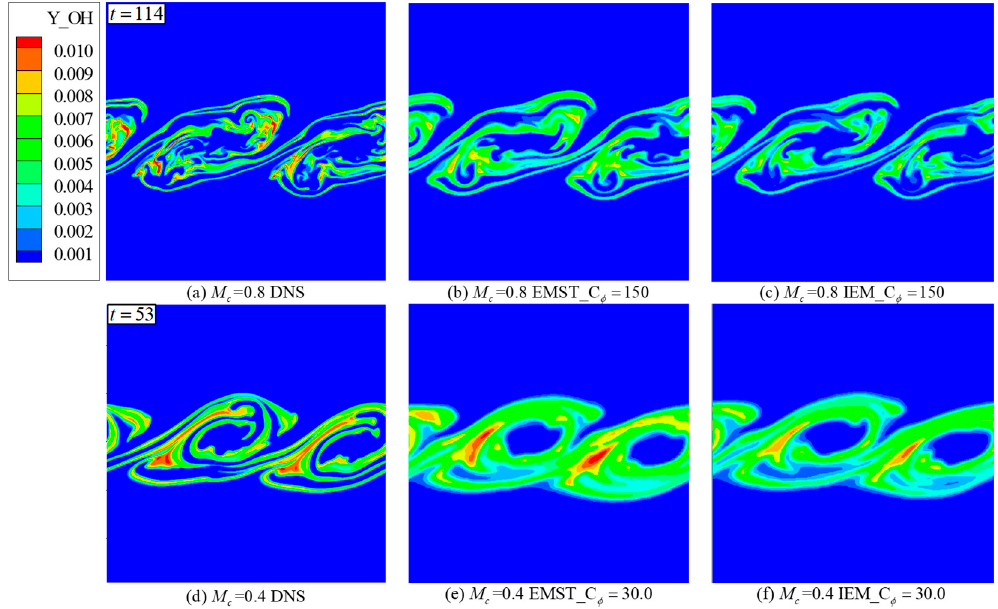
Figure 11. Instantaneous results of OH mass fraction calculated by real hydrogen/oxygen reaction (ii): contour plots for